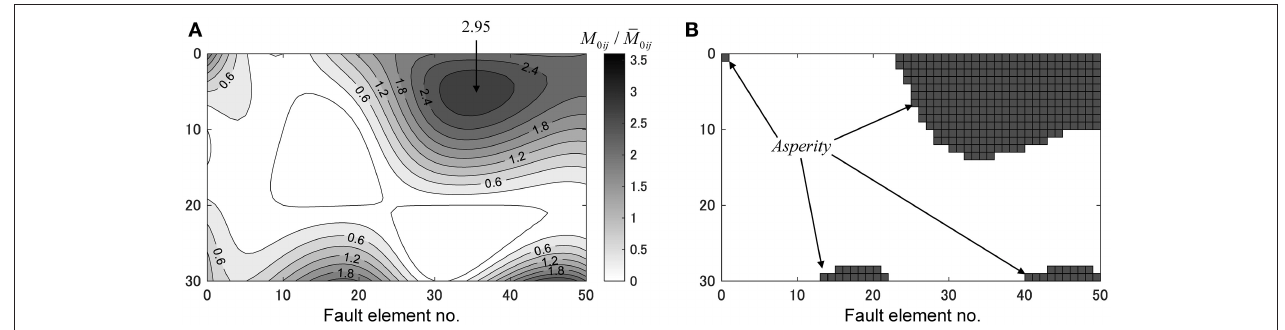
FIGURE 6 | Critical fault model. (A) Distribution of critical seismic moment ratio. (B) Distribution of asperity.